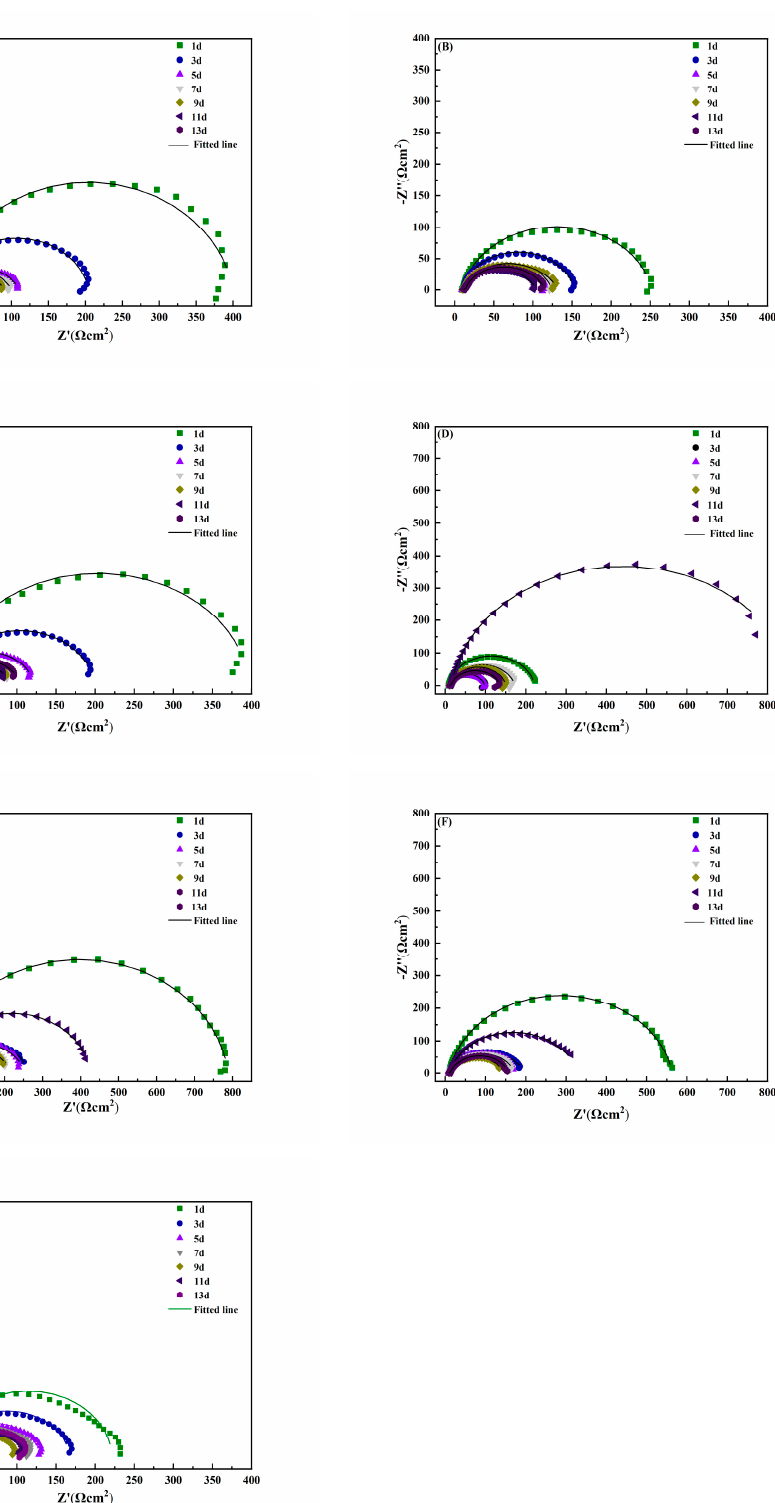
Figure 2. Electrochemical impedance spectra for AZ31B magnesium alloy immersed in 3.5% NaCl solution with different concentrations of simulated inorganic metabolites for different times. ( A – C ): soaked in 0.2, 0.4, and 0.6 mmol/L phosphate in 3.5% NaCl solution; ( D – F ): soaked in 3.5% NaCl solution with 2, 4, and 6 mmol/L sulphur ion concentration; ( G ): 3.5% NaCl solution.